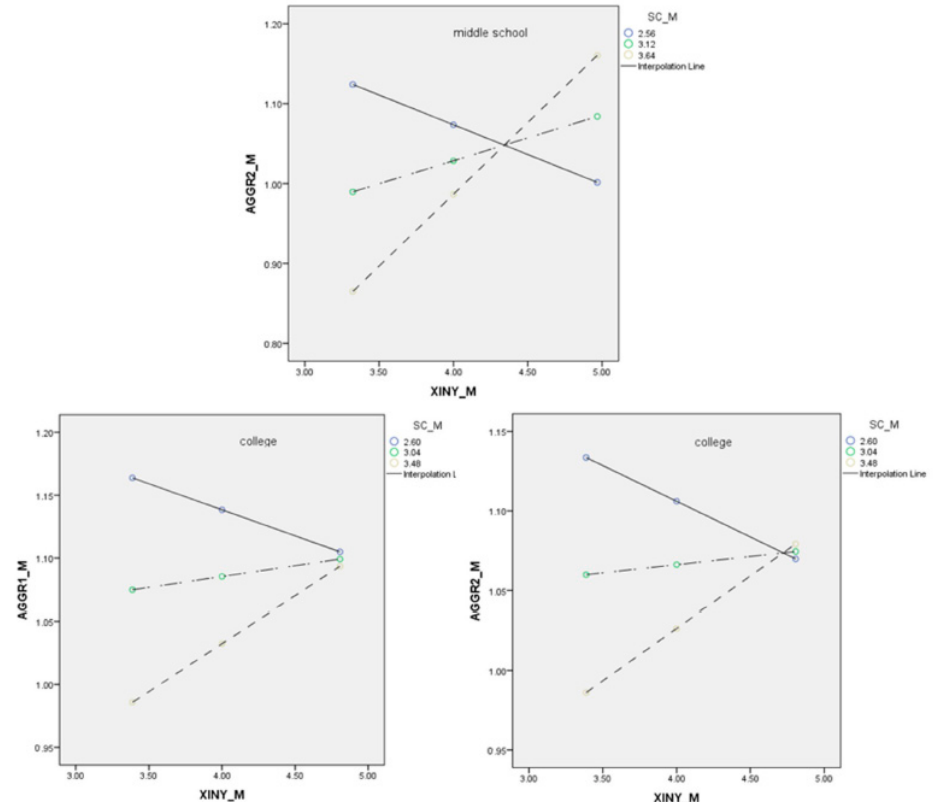
Figure 2. Direct path with school climate being the moderator. Note: XINY = spirituality, AGGR1 = Figure 2. direct path with school climate being the moderator . Note: XINY = spirituality, AGGR1 = instrumental cyberaggression, AGGR2 = reactive cyberaggression, SC = school climate. instrumental cyberaggression, AGGR2 = reactive cyberaggression, SC = school